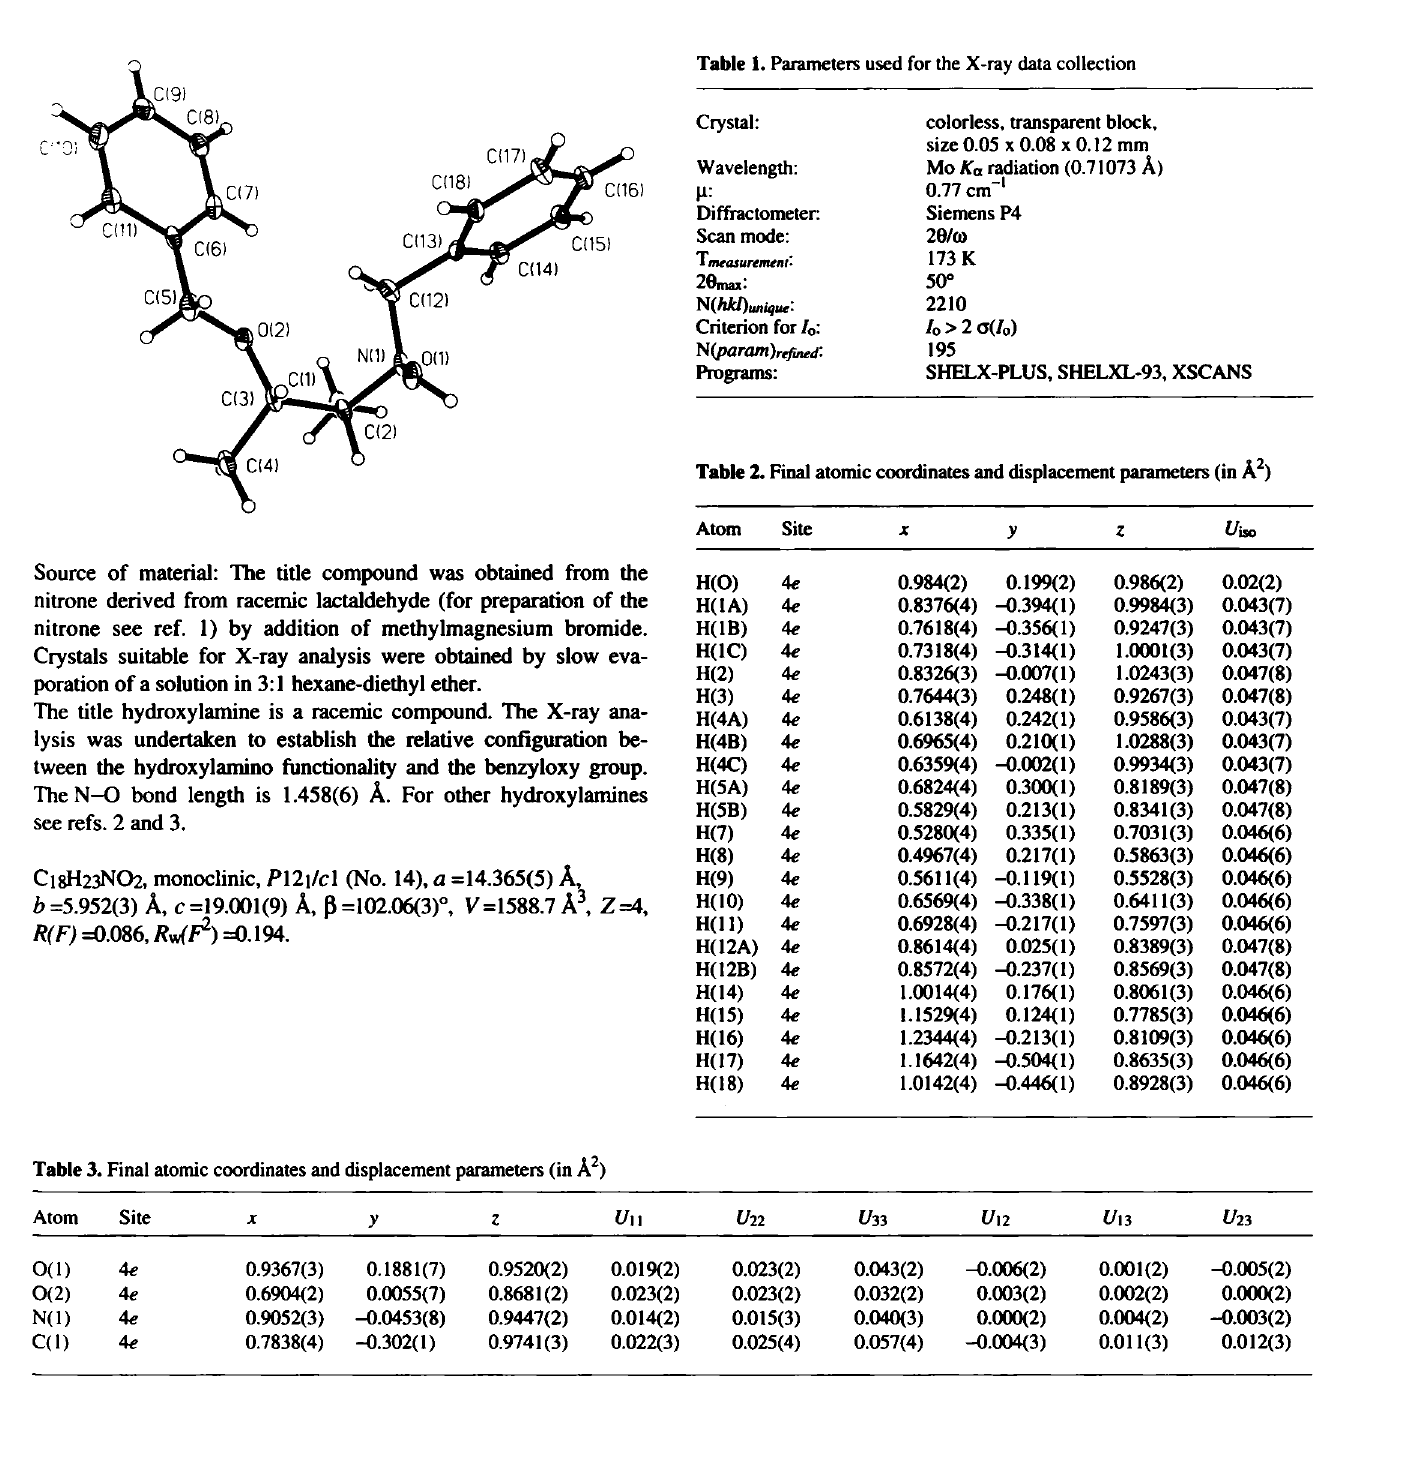
Table 1. Parameters used for the X-ray data collection Crystal: